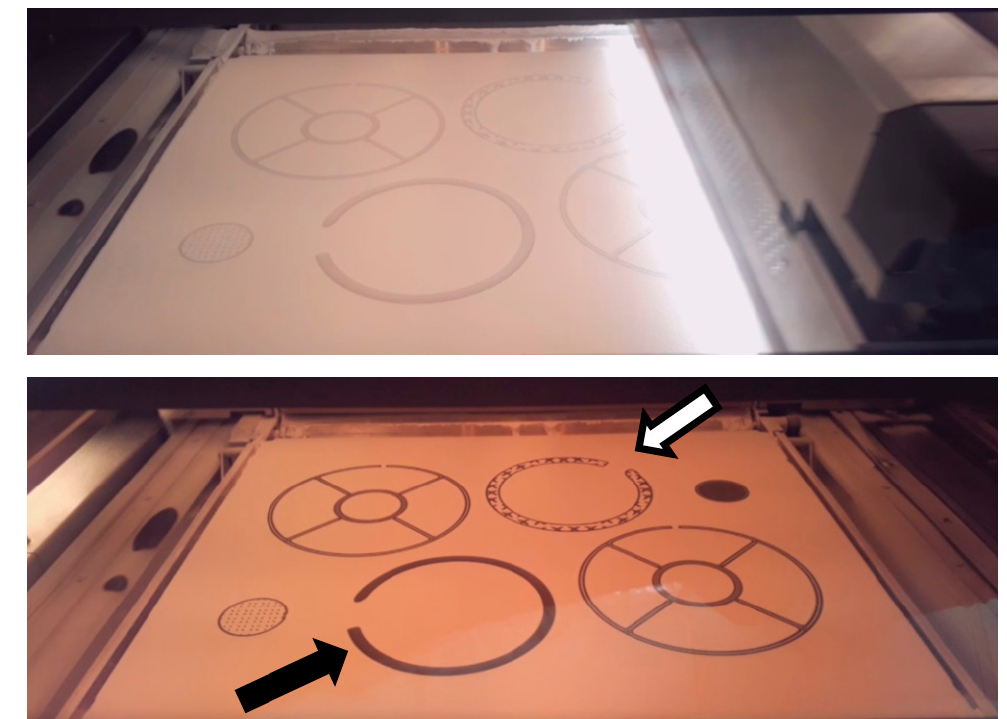
Figure 18. Comparison between lattice and full structure during printing.